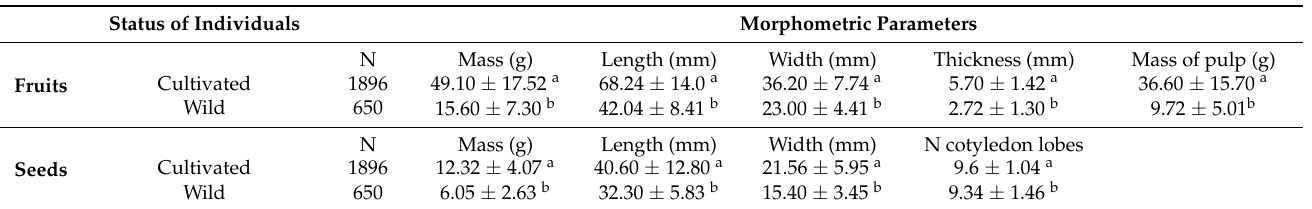
Table 3. Fruits and seeds morphometric characteristics in wild and cultivated populations of D. edulis .